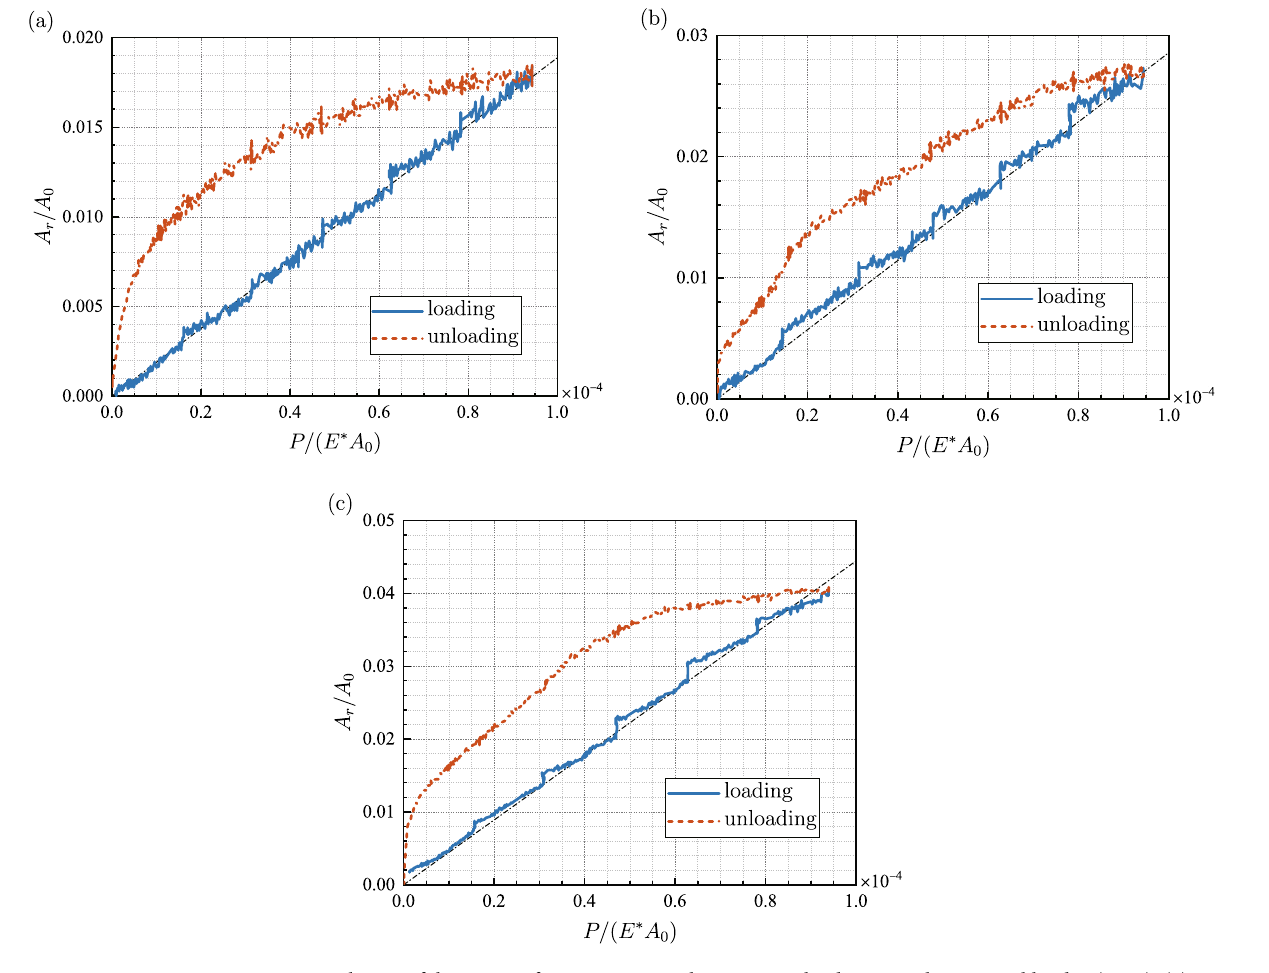
Figure 4. Evolution of the contact fraction A r / A 0 with respect to the dimensionless normal load P /( E*A 0 ): ( a ) sample S1, ( b ) sample S2, ( c ) sample S3.